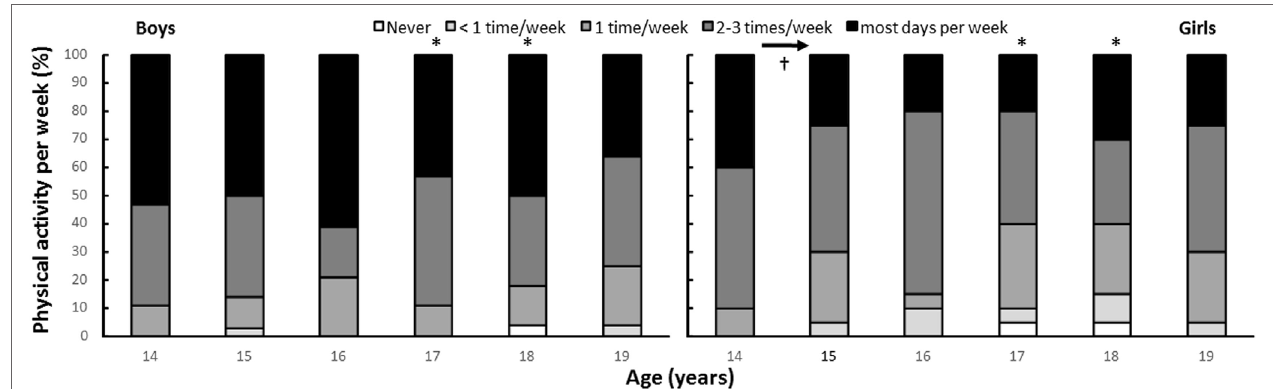
FigUre 2 | Self-reported physical activity (PA) per year by gender (boys: n = 29, girls: n = 20). * indicates a significant gender difference at this age at a p < 0.05 level. † indicates significantly higher self-reported PA compared with all other